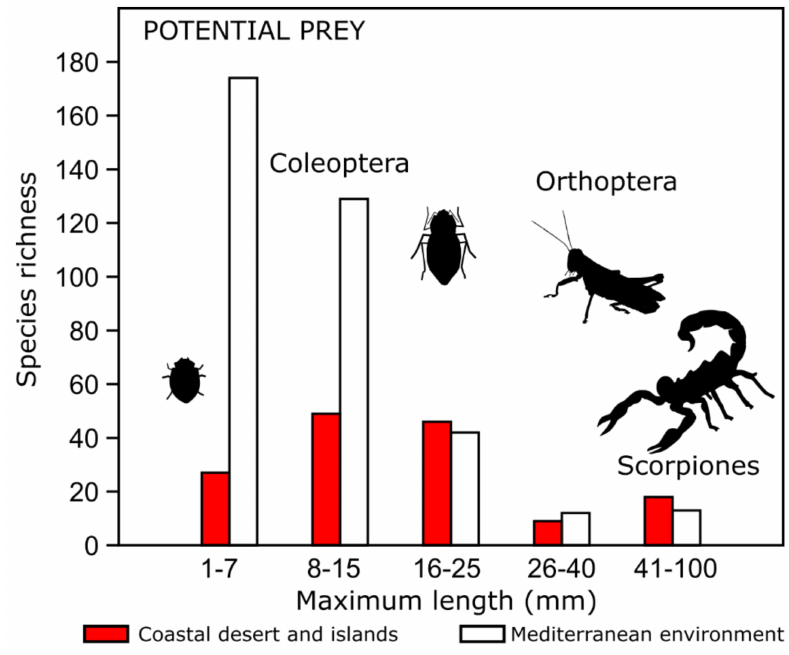
Figure 6. Arthropod prey richness by size. Coastal desert ( T. e. coquimbensis and insular populations) and Mediterranean environment ( T. e. elegans